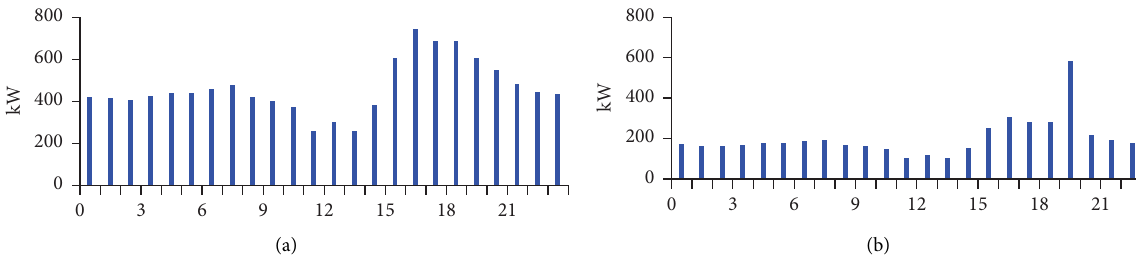
Figure 3: Hourly load profle of (a) AC load and (b) DC load.